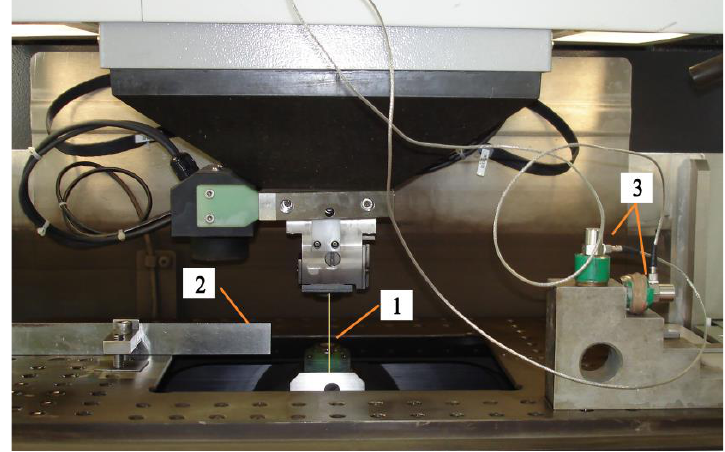
Figure 1. Composition of equipment for monitoring AE signals in WEDM of hard alloys: a — wire-tool; b — workpiece; c — working table; d — accelerometers; e — preamplifiers; f — amplifiers